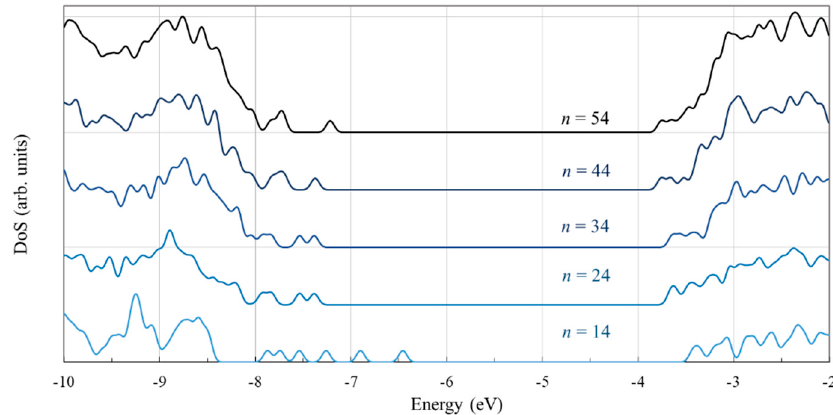
Figure 18. Density of states (DoS) of the systems consisting of the PV molecule adsorbed on the Ti n O 2 n +2 H 4 clusters ( n = 14, 24, 34, 44, 54). Calculations were performed by DFT at the B3LYP/LANL2DZ level in water solvent. Energy levels were convoluted with Gaussian distributions with a 0.1 eV full width at half maximum.